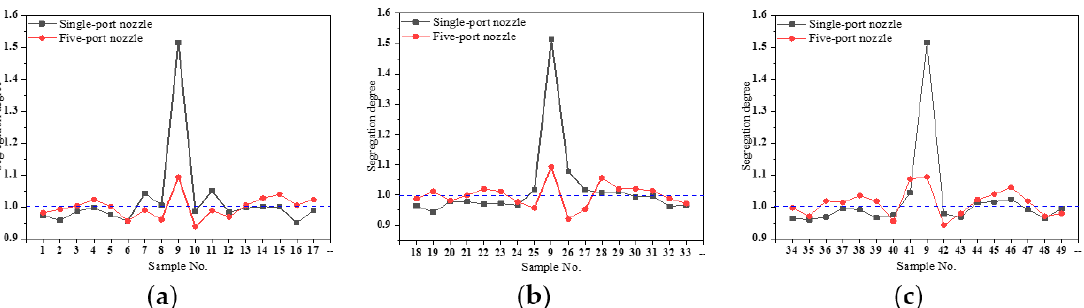
Figure 13. Segregation profiles of C along the cross section of bloom castings of carbon 45 steel: ( a ) left to right direction; ( b ) diagonal direction; ( c ) from the inner side to the outer